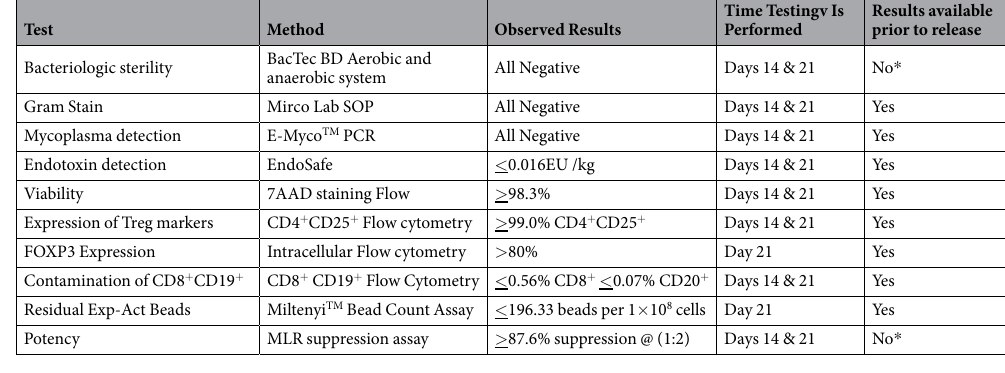
Table 1. Product specifications of the released expanded Treg products (n = 9) ** . * Day 14 in-process testing was taken into consideration for the release of the Treg product. ** All products met or exceeded IND approved release criteria. Prior to unit infusion, the above release criteria were confirmed and reported to the clinician and regulatory